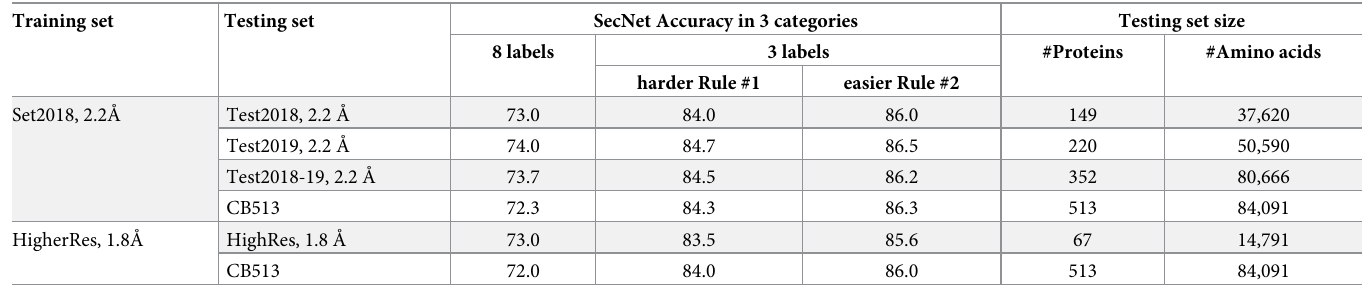
Prediction accuracies are measured in 3 categories: 8 DSSP labels; the most common and harder 3-label Rule #1 : ( H , G , I ) ! H , ( E , B ) ! E , (rest 4 labels) ! C; and